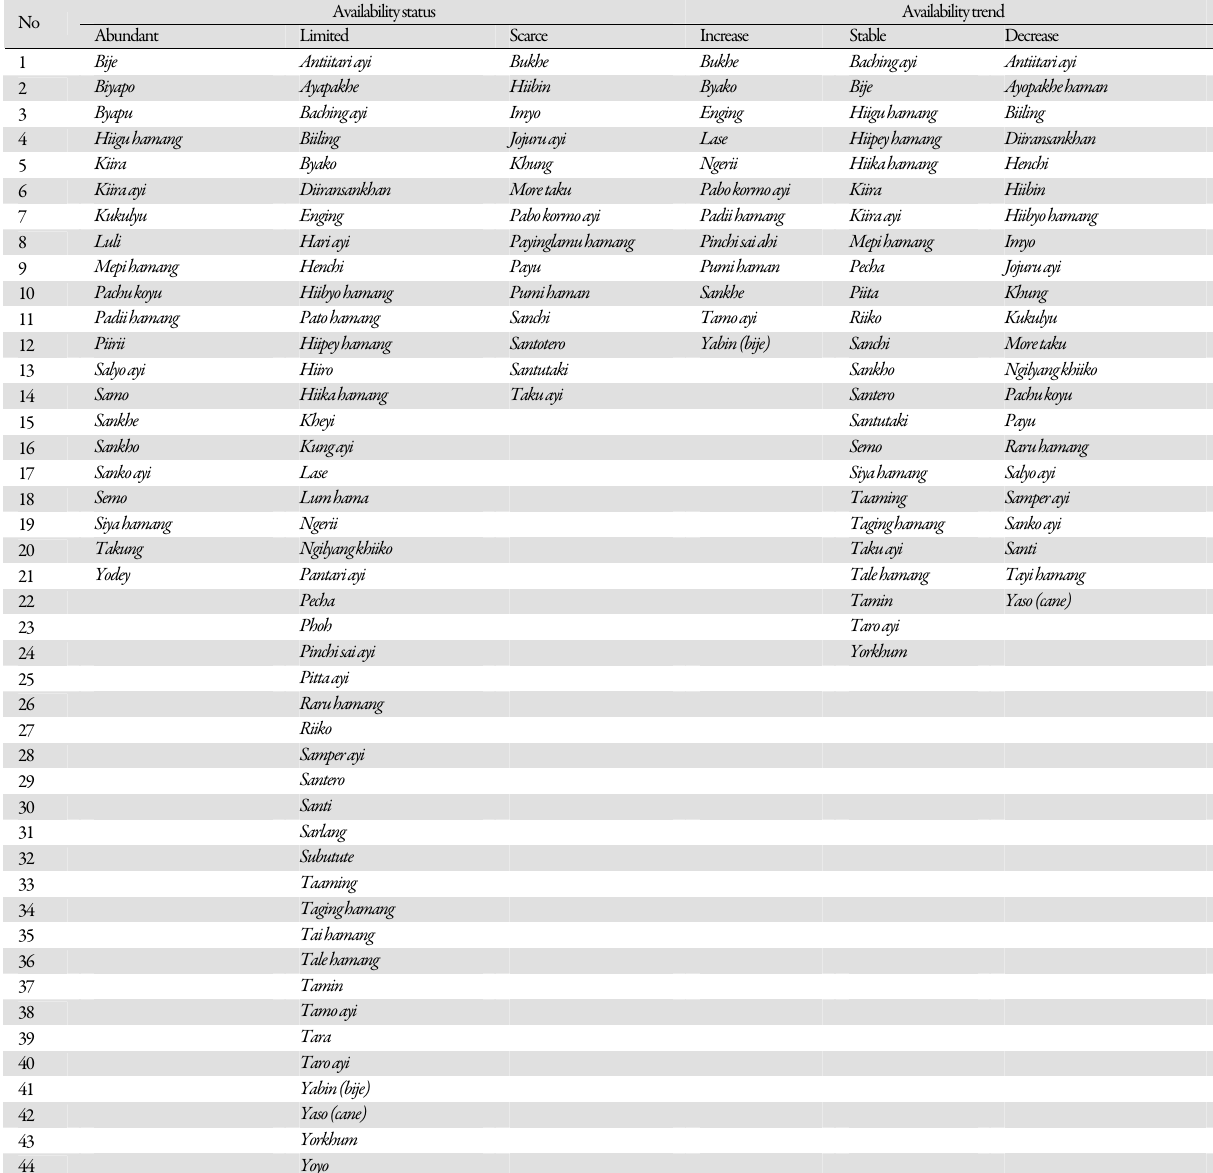
Table 3. Category wise list of ecologically important NTFPs based on 10-15 years experience of the respondents